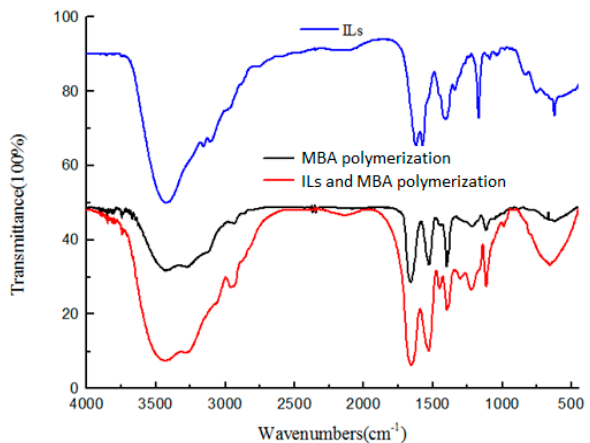
Figure 3. The IR spectrum of IL, MBA and Pol c.